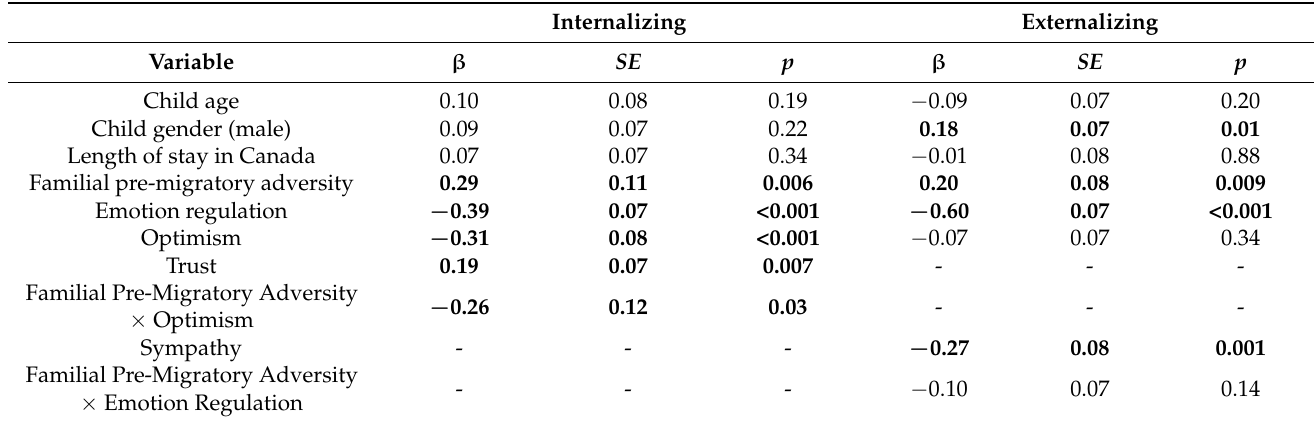
Table 2. Merged regression model predicting child internalizing and externalizing